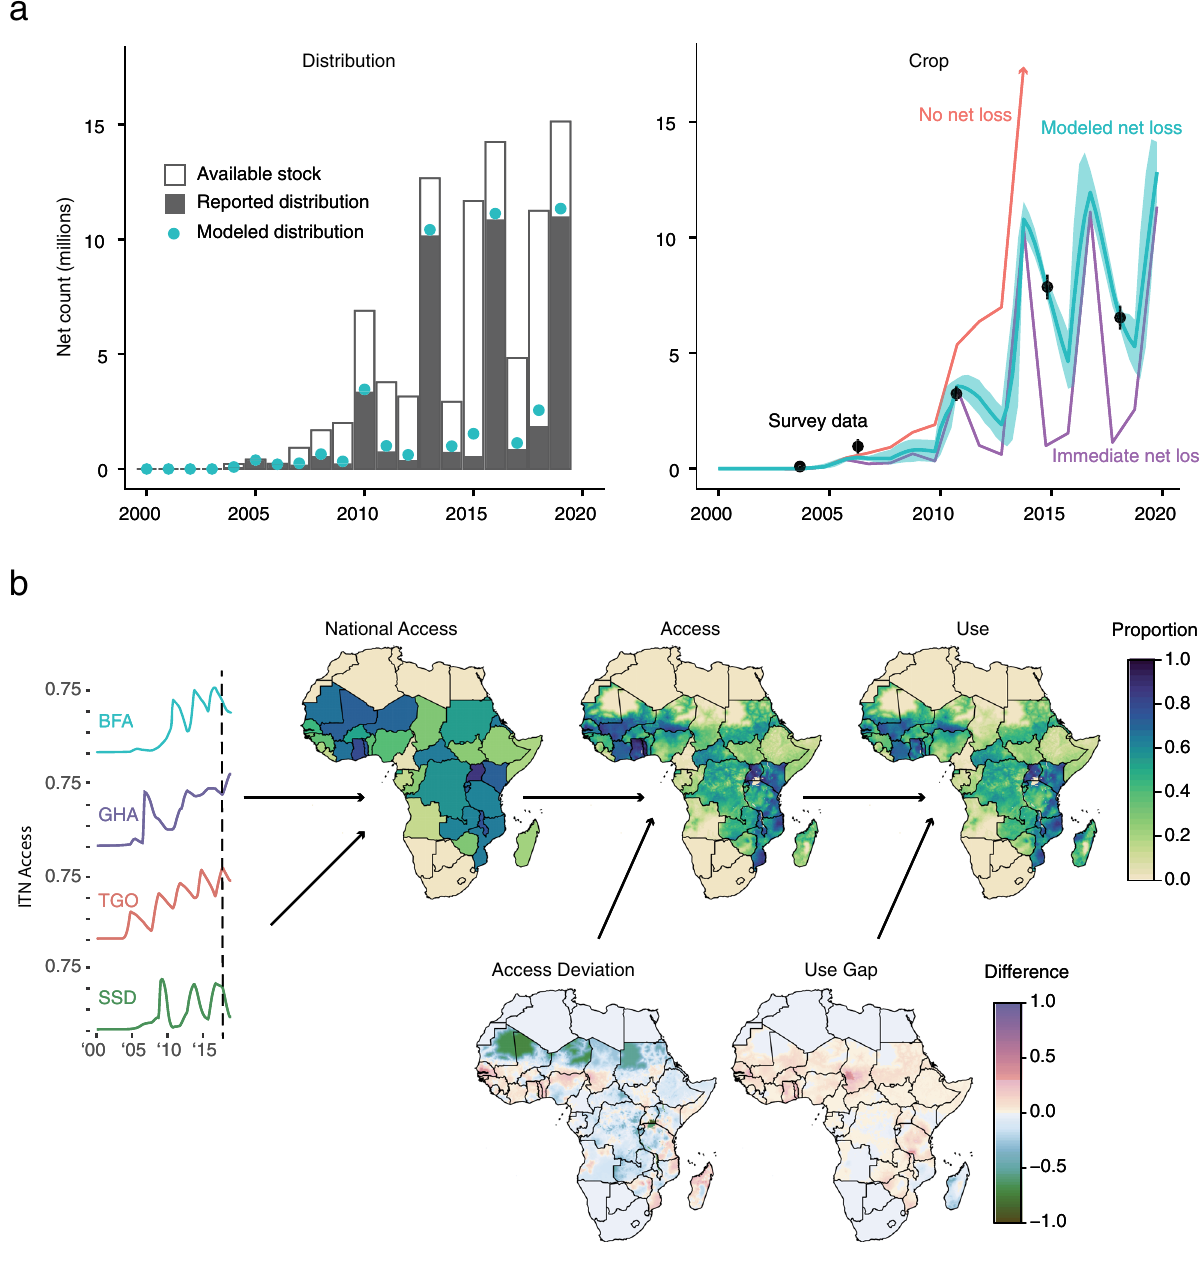
Fig. 1 Insecticide-treated net (ITN) model summaries. a Mechanistic “ stock-and- fl ow ” model. For each country (Burkina Faso shown for reference), the number of nets distributed must be no less than the reported distribution count and no more than the available stock (solid bars, left). Net loss follows an S-shaped curve whose steepness is fi tted according to survey data (right). If nets were never discarded, net crop would increase cumulatively with every distribution (red line), whereas if nets were discarded immediately, net crop would equal net distribution (purple line). The fi tted curve (blue line and 95% con fi dence interval) balances these two extremes. b Geostatistical regression model. After net crop time series are converted to net access time series, geospatial regression models are run on the difference metrics of “ access deviation ” and “ use gap. ” Final maps of ITN access are calculated by adding national access and access deviation, while fi nal maps of ITN use are calculated by adding access and use gap. Maps of nets-per-capita are calculated similarly to access. BFA Burkina Faso, GHA Ghana, TGO Togo, SSD South Sudan. These four access time series are shown as examples, but 40 countries are included in the of 61.8% in the most recent 2019 survey. This corresponds to a use gap of 25.2 percentage points. The modeled estimate of use gap in Ghana for 2019 was 22.8 (19.5, 25.8) percentage points, while the aggregated all-country estimates for use rate and use gap were 87.1% (83.3, 90.1) and 5.69 percentage points (4.53, 7.02), respectively.